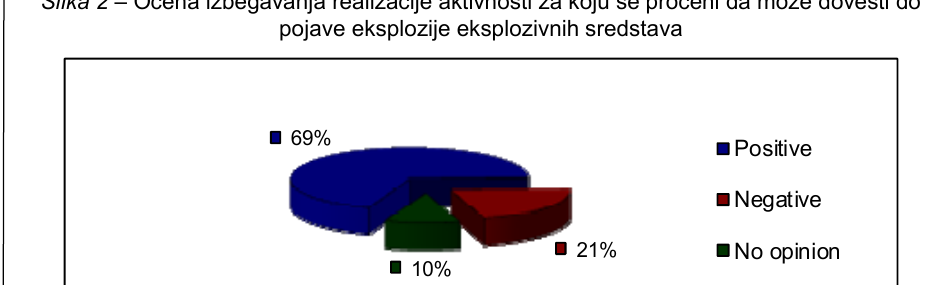
Figure 3 – Assessment of the mitigation of hazards, risks and threats from the effects of the explosion of explosive materials in a subconscious manner Рис . 3 – Оценка смягчения опасности , рисков и угроз от взрыва взрывчатых средств , на подсознательном